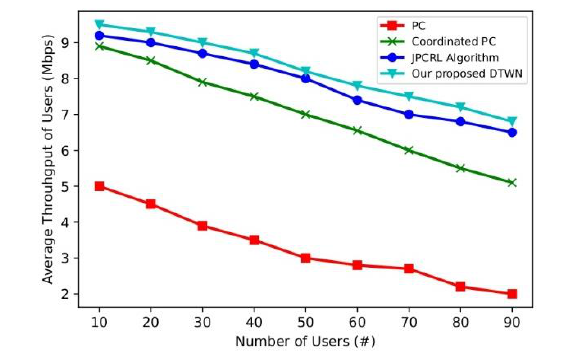
Figure 9. Average throughput versus number of